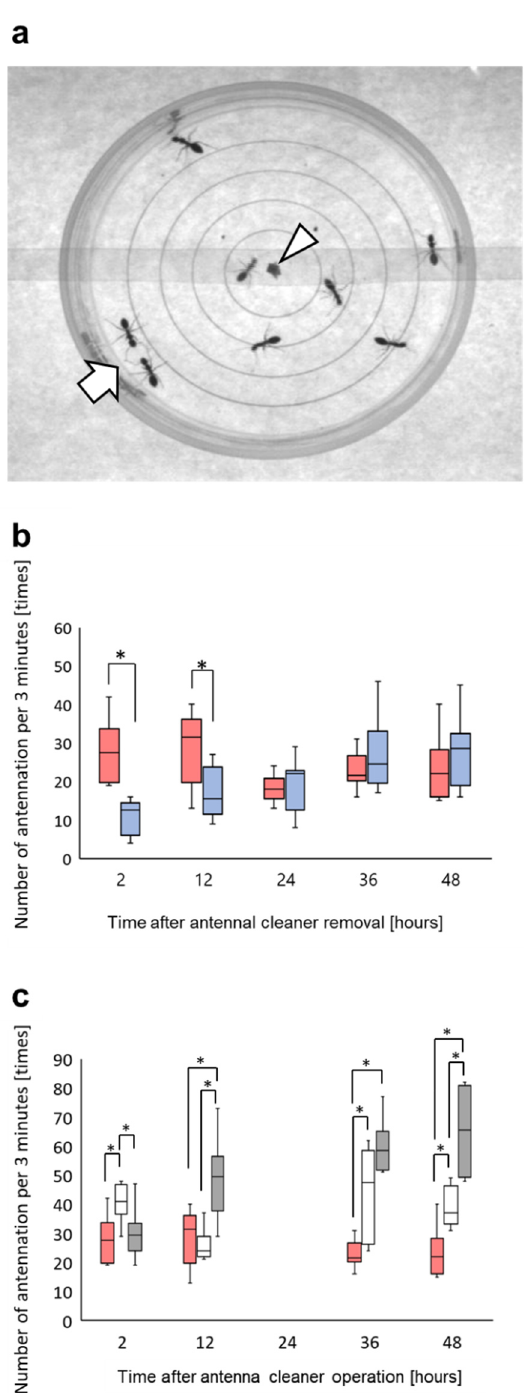
Figure 4. Frequency of antennation between antennae of ants in the presence of undecane and/or n -hexane. ( a ) Locomotion arena for video recording. An arrowhead indicates the position of releaser for undecane and/or n -hexane. An arrow indicates two individual ants exhibiting antennation between their antennae. ( b ) Such an antennation frequency per 3 min is plotted against time after the antenna cleaner removal operation. Red and blue columns indicate the antennation frequency in the presence of undecane diluted in n -hexane and plain n -hexane, respectively. ( c ) Red columns are the same as those in ( b ), but white and gray columns indicate the sham-operated ants’ antennation per 3 min in the presence of undecane diluted in n -hexane and plain n -hexane, respectively. Asterisks indicate significant difference (Wilcoxon signed rank test, p < 0.05, n = 8).